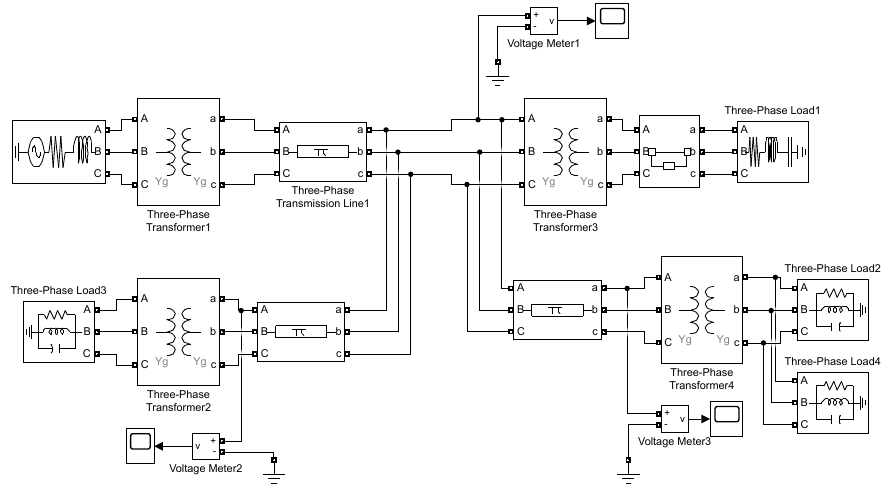
Figure 2. Simulink system for generating voltage swell disturbance induced by sudden load decrease.